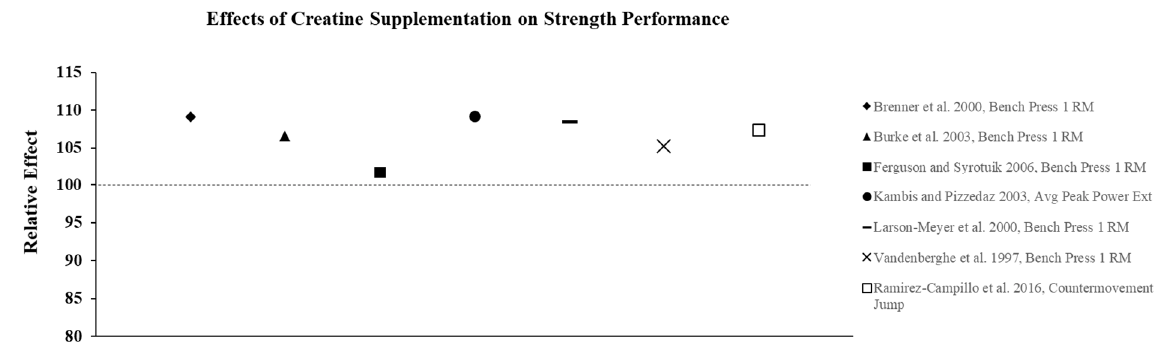
Nutrients 2021 , 13 , x FOR PEER REVIEW